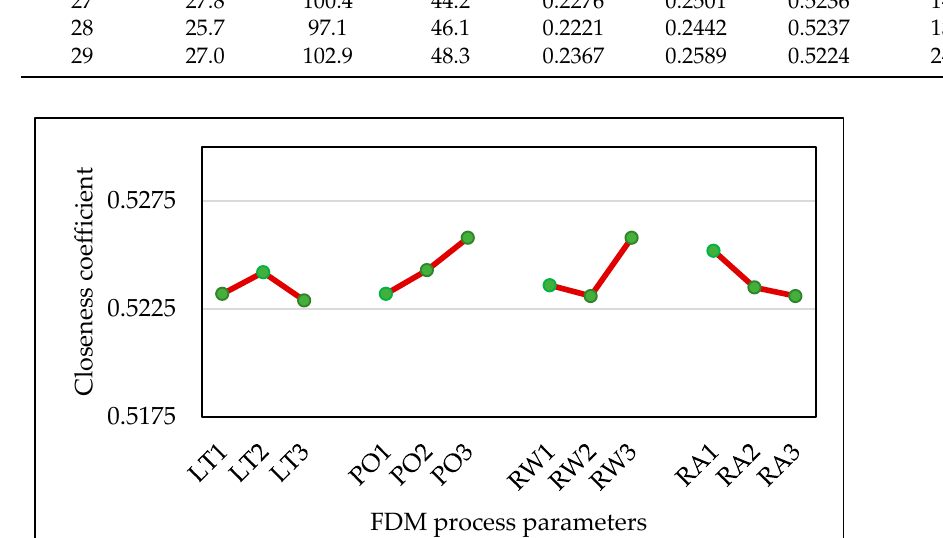
Figure 8. Closeness coefficient values for each experimental specimen.